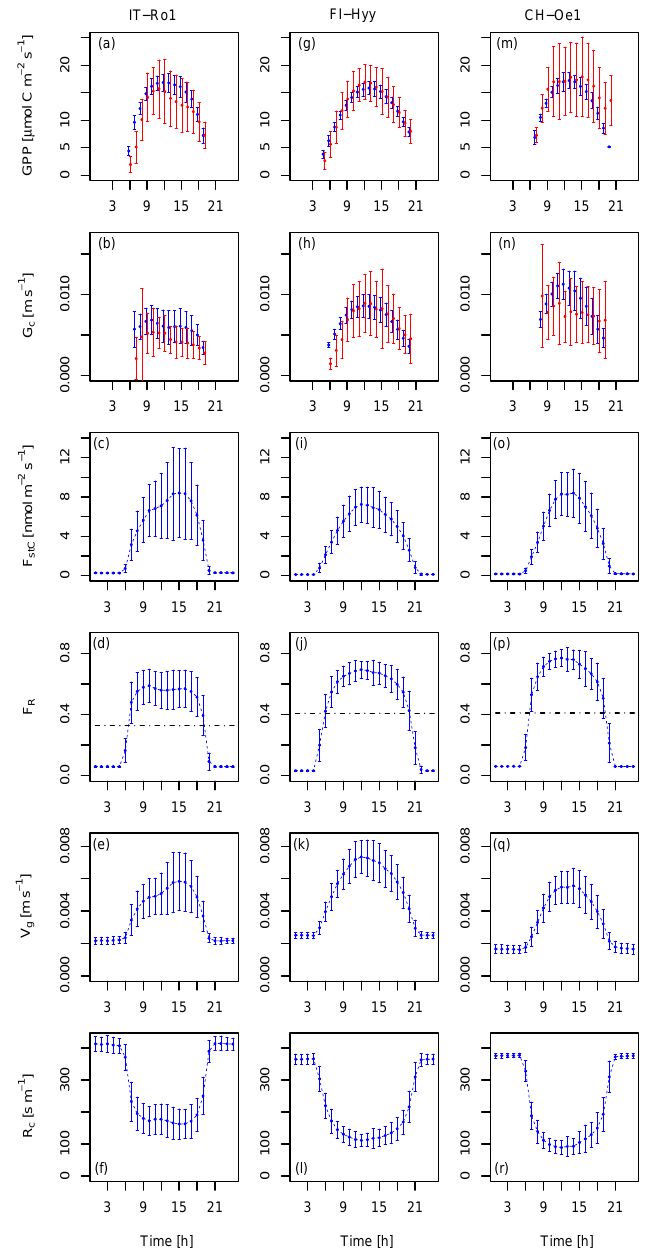
Figure 2. Simulated and observed hourly means over all days of the months of July of 2002–2006 for CH-Oe1 and IT-Ro1, as well as for 2001–2006 for FI-Hyy. Plotted are mean hourly values (local time) of (a, g, m) GPP (blue: OCN; red: FLUXNET), (b, h, n) canopy conductance ( G c ) (blue: OCN; red: FLUXNET), (c, i, o) O 3 uptake ( F stC ), (d, j, p) the flux ratio ( F R ), (e, k, q) O 3 deposition velocity ( V g ), and (f, l, r) O 3 surface resistance ( R c ). The error bars indicate the standard deviation from the hourly mean. The dotted line in panels (d) , (j) , and (p) indicates the daily mean value.